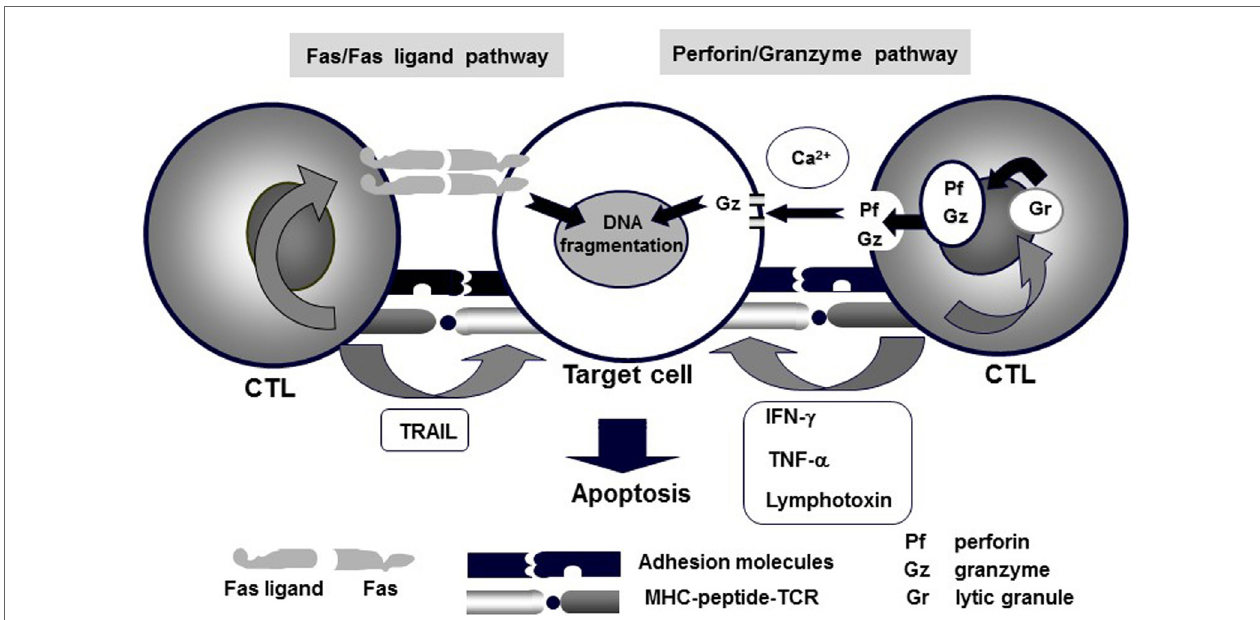
FiGURe 1 | Mechanisms of CTL-mediated cytotoxicity . Various pathways, including perforin/granzyme, Fas/Fas ligand, membrane-bound TNF- α , membrane- bound lymphotoxin, and TRAIL, underlie CTL-mediated cytotoxicity. Among these, granule exocytosis that is mediated by the perforin/granzyme and Fas/Fas ligand pathways are believed to be the main mechanisms of CTL-mediated antigen-specific